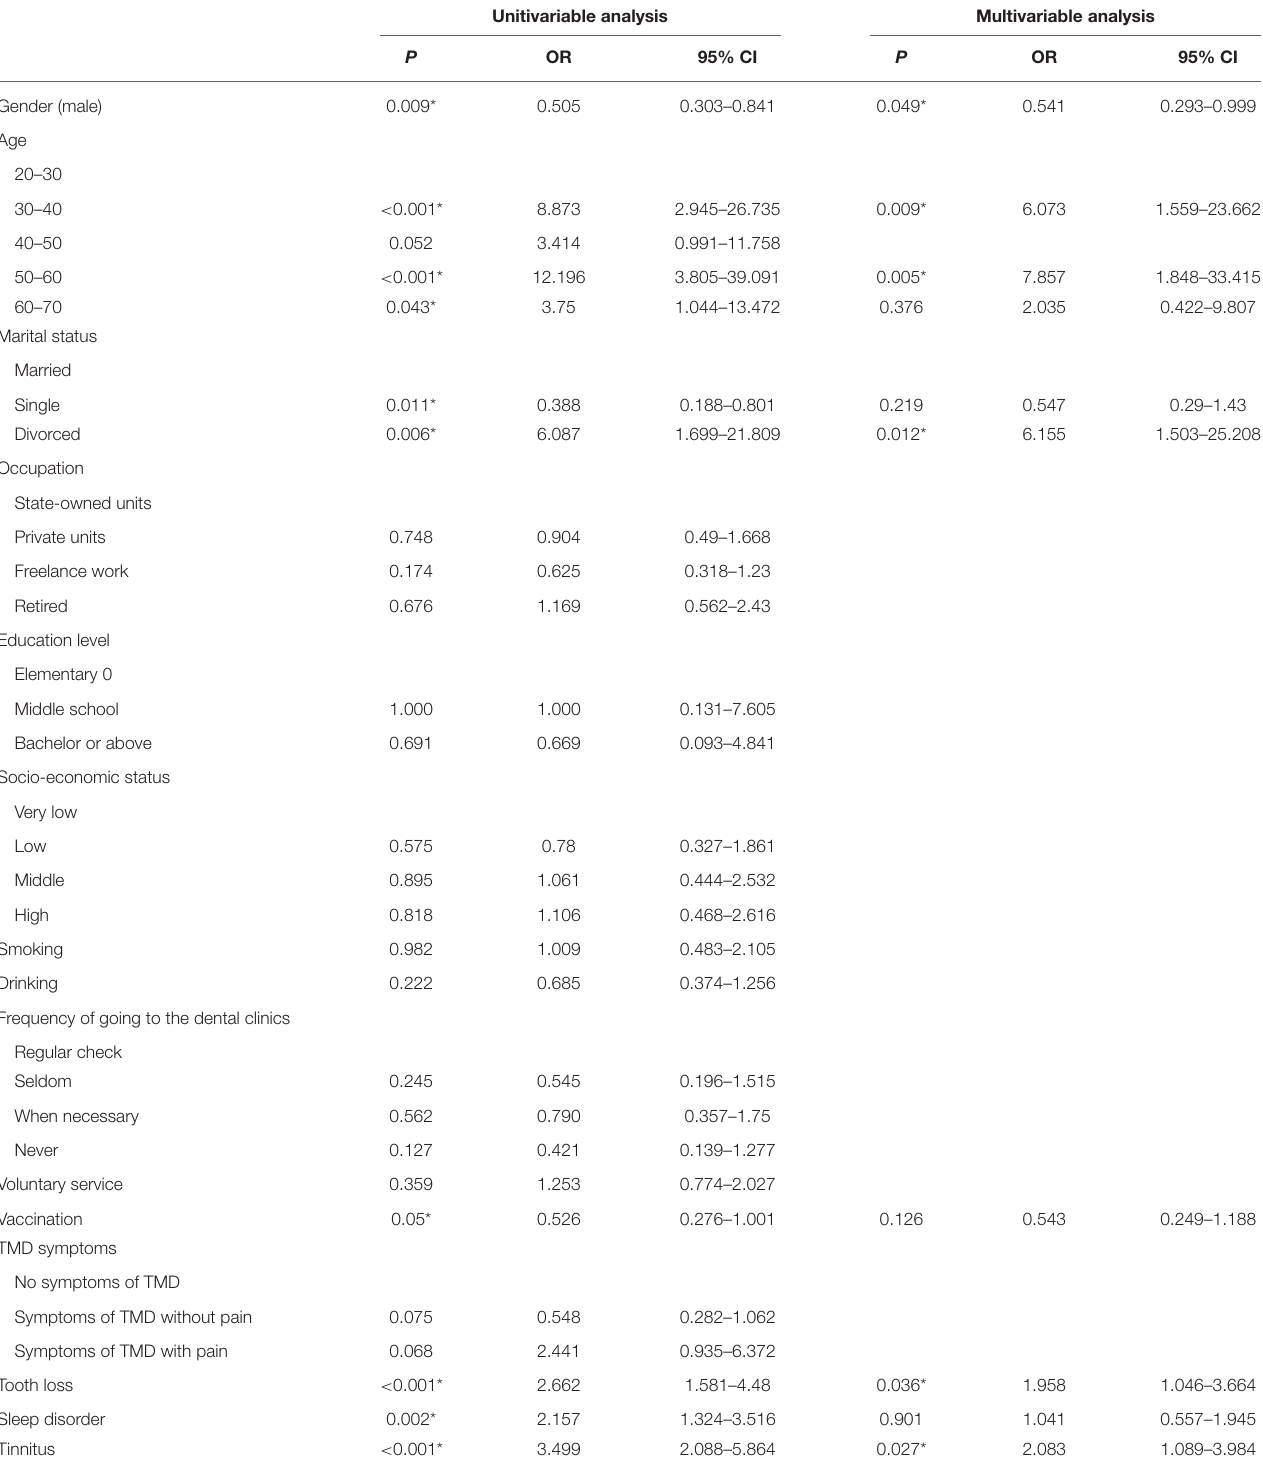
TABLE 7 | Factors of the occurrence of depression. Unitivariable analysis Multivariable